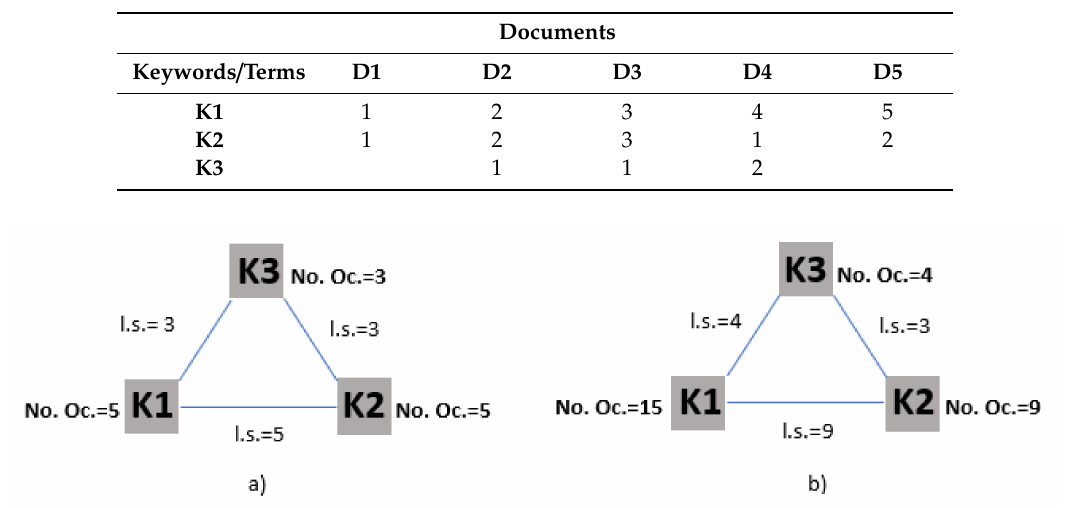
Figure 2. Co-occurrence network of keywords, ( a ) binary counting method, ( b ) full counting method.